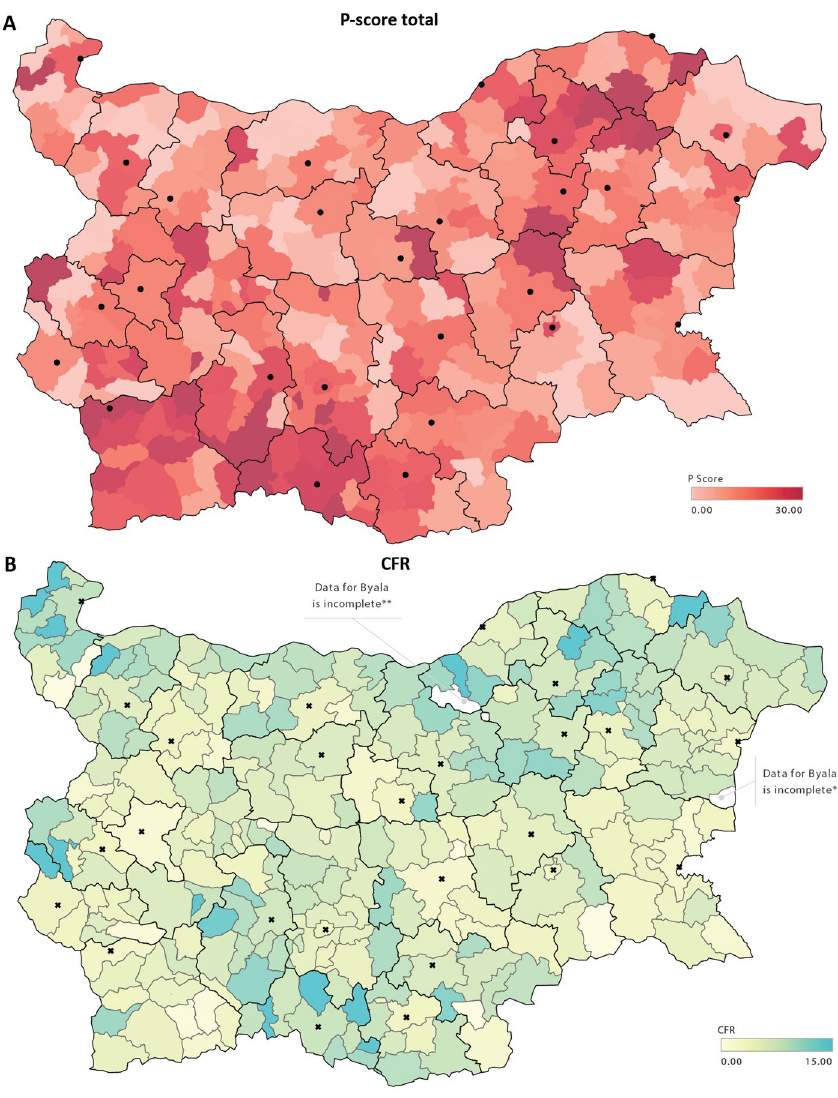
Figure 6. Regional disparities in the impacts of the COVID-19 pandemic in Bulgaria at the county/ municipality level. ( A ) Overall excess mortality in Bulgaria at the county/municipality level; ( B ) CFR values for Bulgaria at the county/municipality level (note that there are two municipalities named “Byala”, and available data does not distinguish between the two, thus they are colored in white as missing data. Regions are demarcated in black, regional centers are shown as black